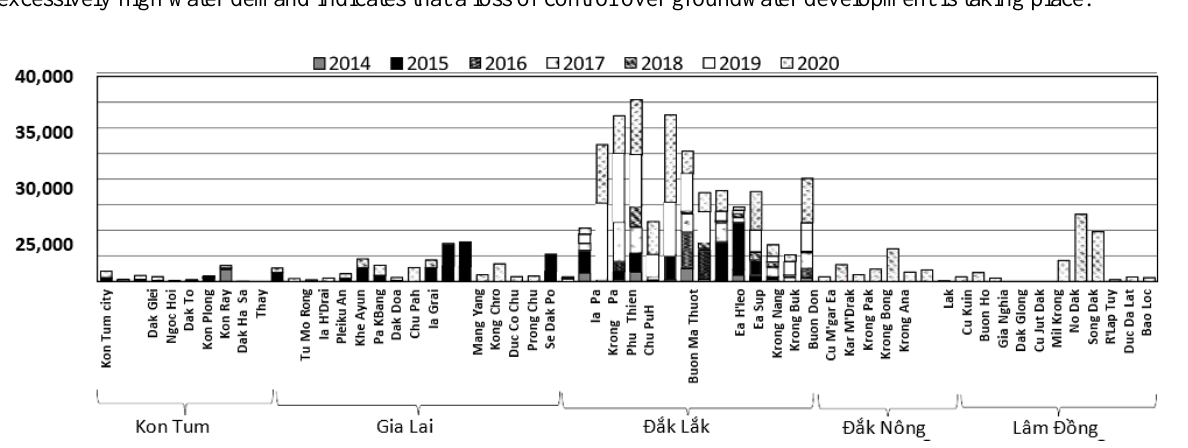
Figure 3. Area of crops damaged by drought in the Central Highlands provinces from 2014 to 2020